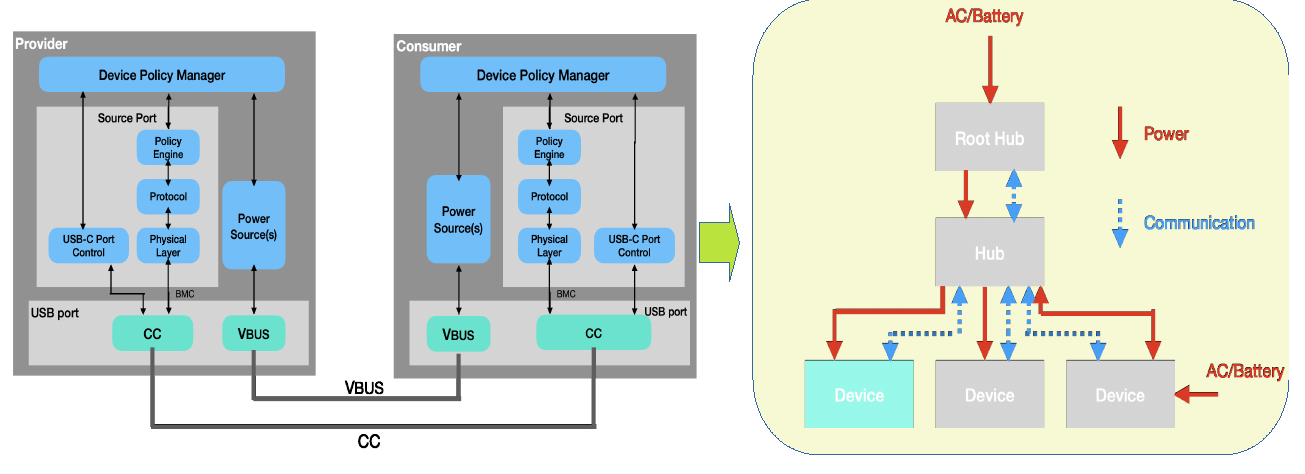
Figure 10. High-level architecture view for PD